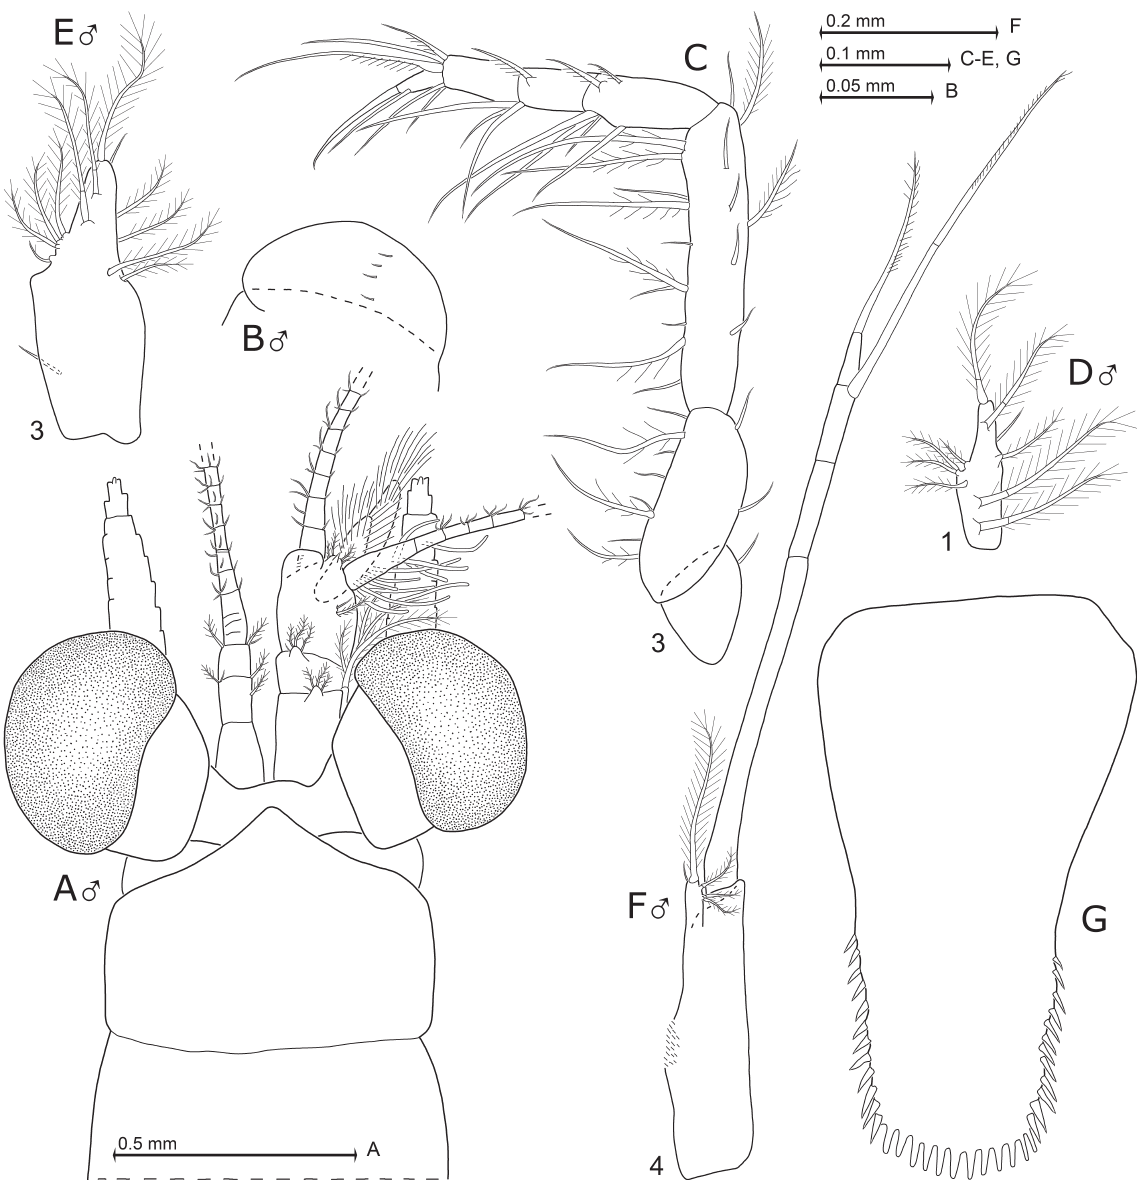
Fig. 4. Mysidium rubroculatum Băcescu & Ortiz, 1984, from Cuba, paratypes. A . ♂, 3.6 mm body length. B–G . ♂, 3.8 mm. A . Cephalic region, left antennula and setae of antennal scale omitted. B . Mediodistal extension of left antennular trunk, dorsal view. C . Third thoracic endopod, rostral view. D – E . Pleopods 1 and 3, rostral view. F . Pleopod 4, caudal view. G